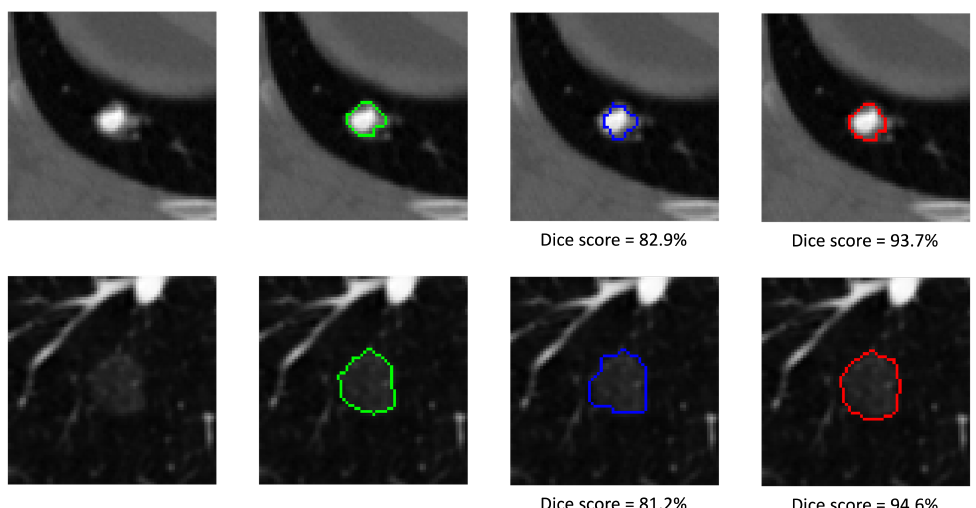
Figure 6. The visual results comparison of the previous cropped-slice-based approach with Res-UNet and full-slice input-based approach with DEHA -Net.